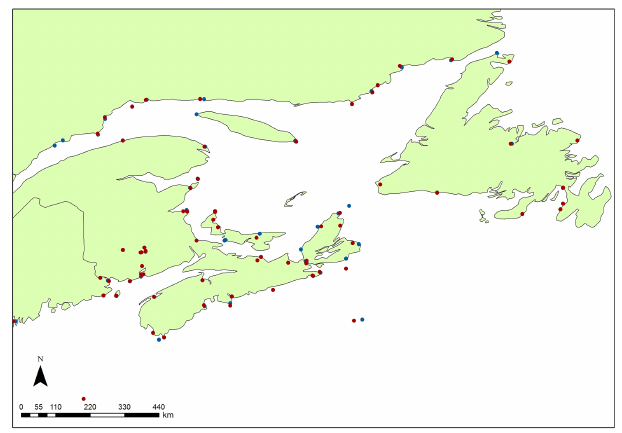
Figure 10. Map of the original station location situated in the ocean (blue dots) and the updated station location (red dots) for eastern parts of